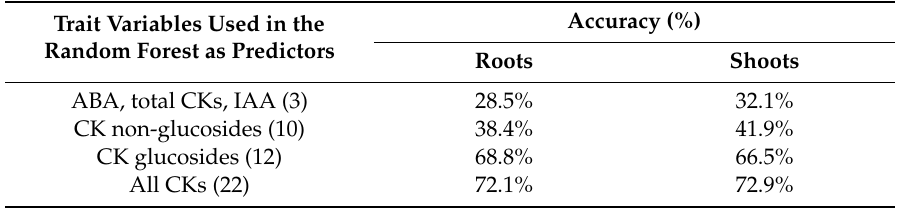
Table 2. Overall classification accuracy of the ecotypes using Random Forest classifier with di ff erent traits using hold-out cross validation. Number of compounds used for analysis is stated in brackets. Trait Variables Used in the